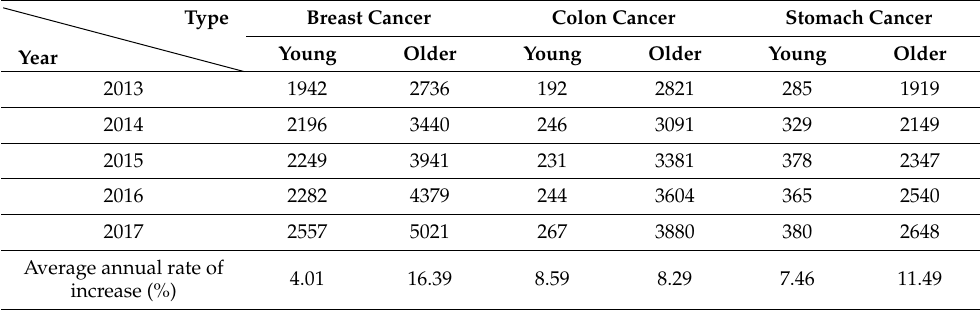
Table 1. Number of cancer survivors in convalescent hospitals by age group.